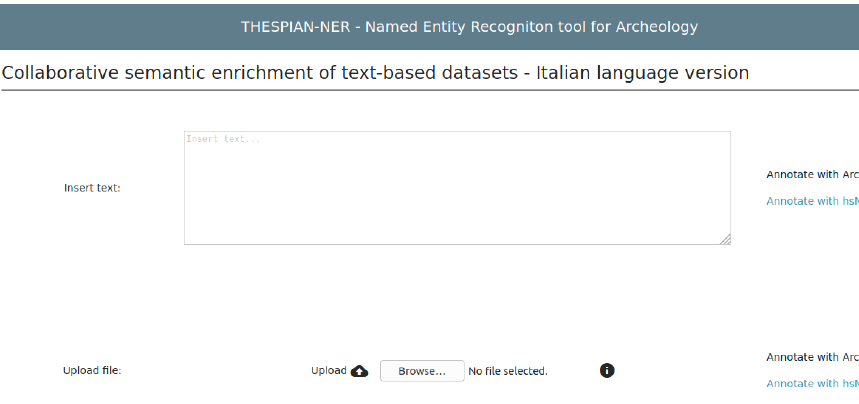
Figure 4. Visual schema on how the THESPIAN–NER service operates.